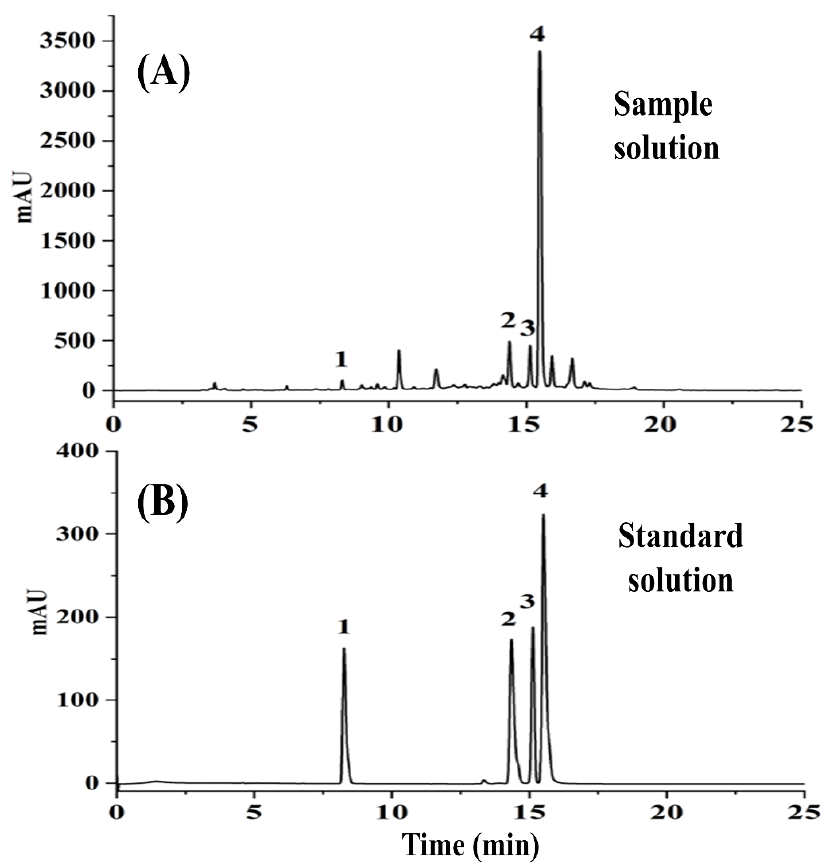
Figure 2. Representative HPLC chromatograms of sample solution ( A ) and standard solution ( B ). 335 real samples were analyzed by the HPLC-DAD method. All four bioactive com- pounds were baseline separated and could be accurately determined. Calibration curves,